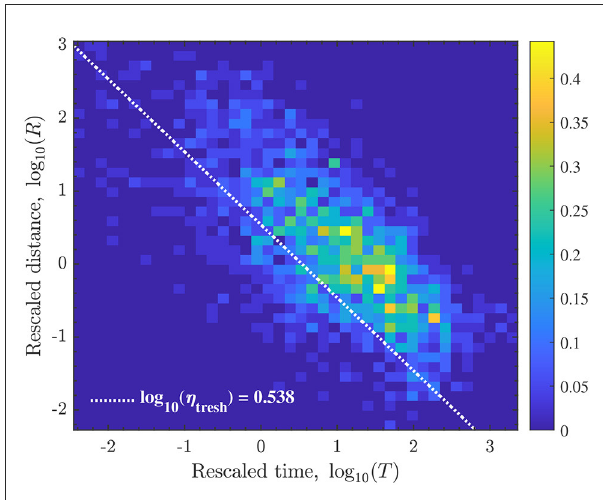
FIGURE9 The normalized density plot of the joint distribution of the rescaled time T and space R . The white dashed line corresponds to the threshold log 10 ( η thresh ) 0.538. =